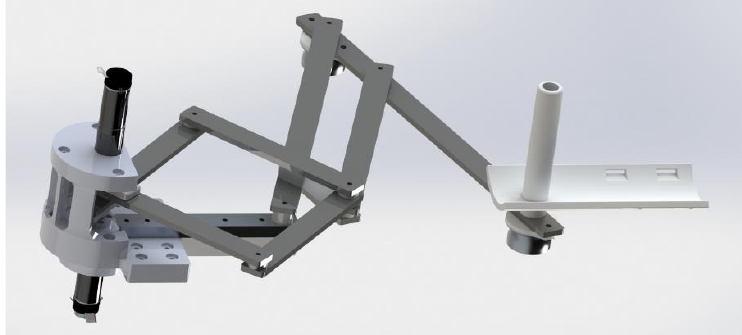
Figure 7. Five critical positions ( a ( − 496, 700), b (496, 700), c ( − 496, 148), d (496, 148), e (0, 424)) within the NURSE workspace.